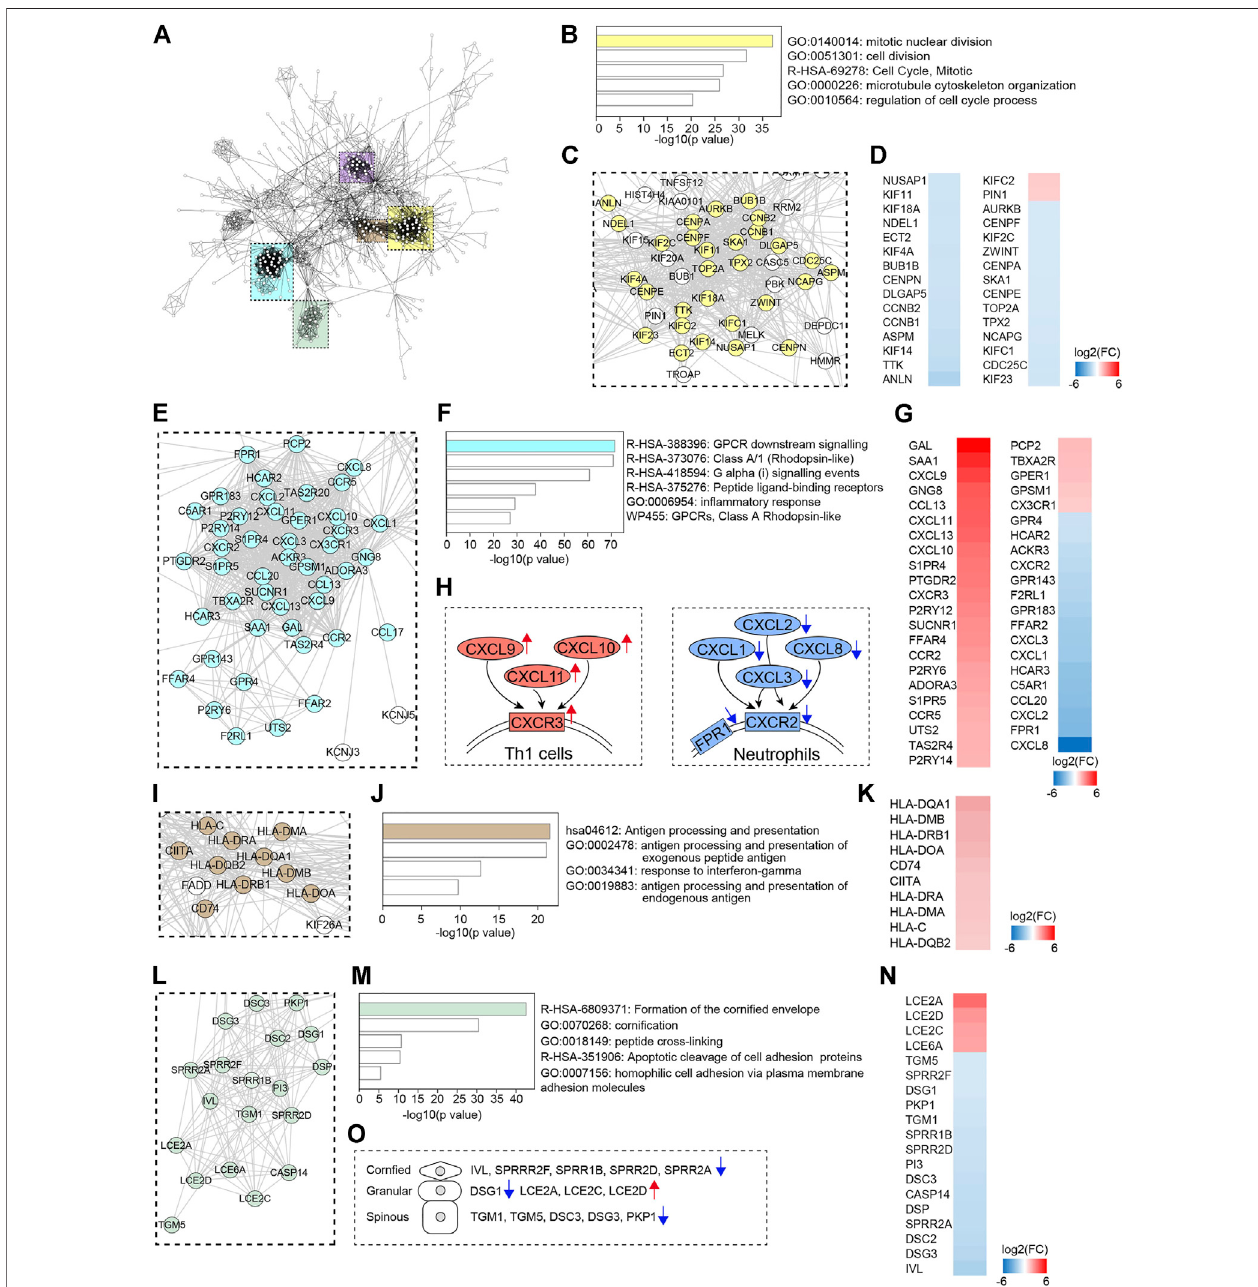
FIGURE 4 | Protein-protein interaction (PPI) network analysis. (A) PPI network of DECGs identi fi ed in LS. Each node represents a protein, and interactions with con fi dencescore > 0.9arepresented.Coloredrectangleboxesindicatedsubnetworks. (B,F,J,M) Metascapeanalysisofindicatedsubnetworks. (C,E,I,L) Subnetworks showingnodeslabeledwithgenename.Genesidenti fi edinthetopcategoryofMetascapeanalysiswerelabeledincolors. (D,G,K,N) Heatmapsshowingfoldchangesof expression of genes labeled in colors. (H) Schematics showing gene expression changes of chemokine-chemokine receptor pairs. (O) Schematics showing changes in the expression of corni fi ed envelope